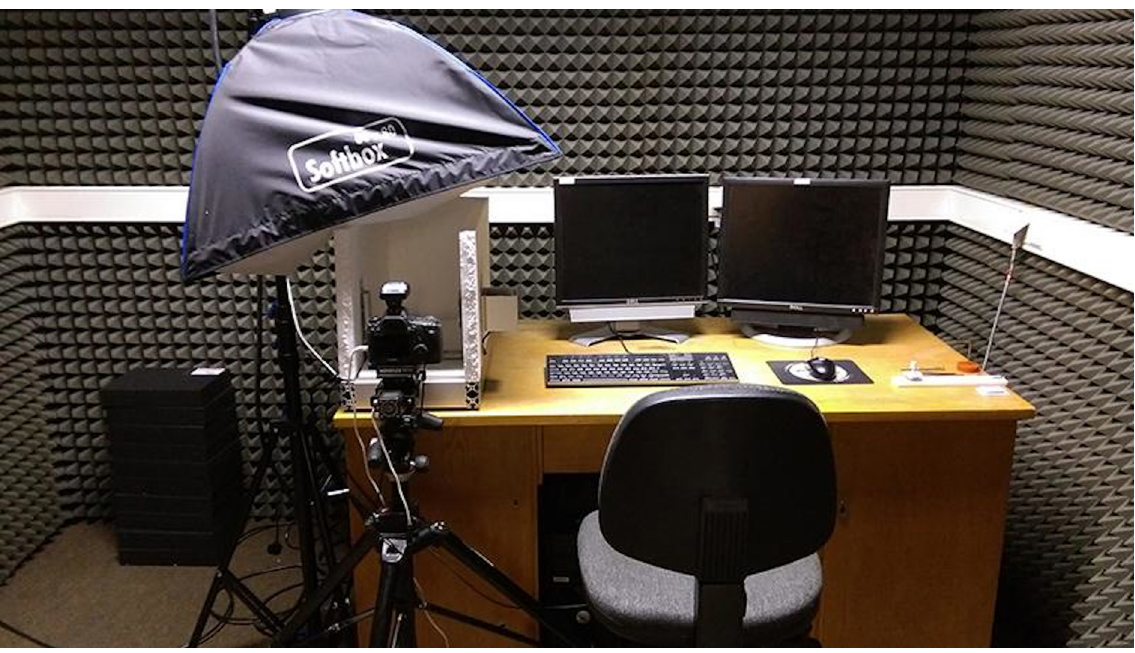
Fig. 2.19. View of the photographic lab of the ZooSphere, with the automated specimen rotator in front of the camera, covered by styrofoam panels to reflect the light in all directions. Image copyright